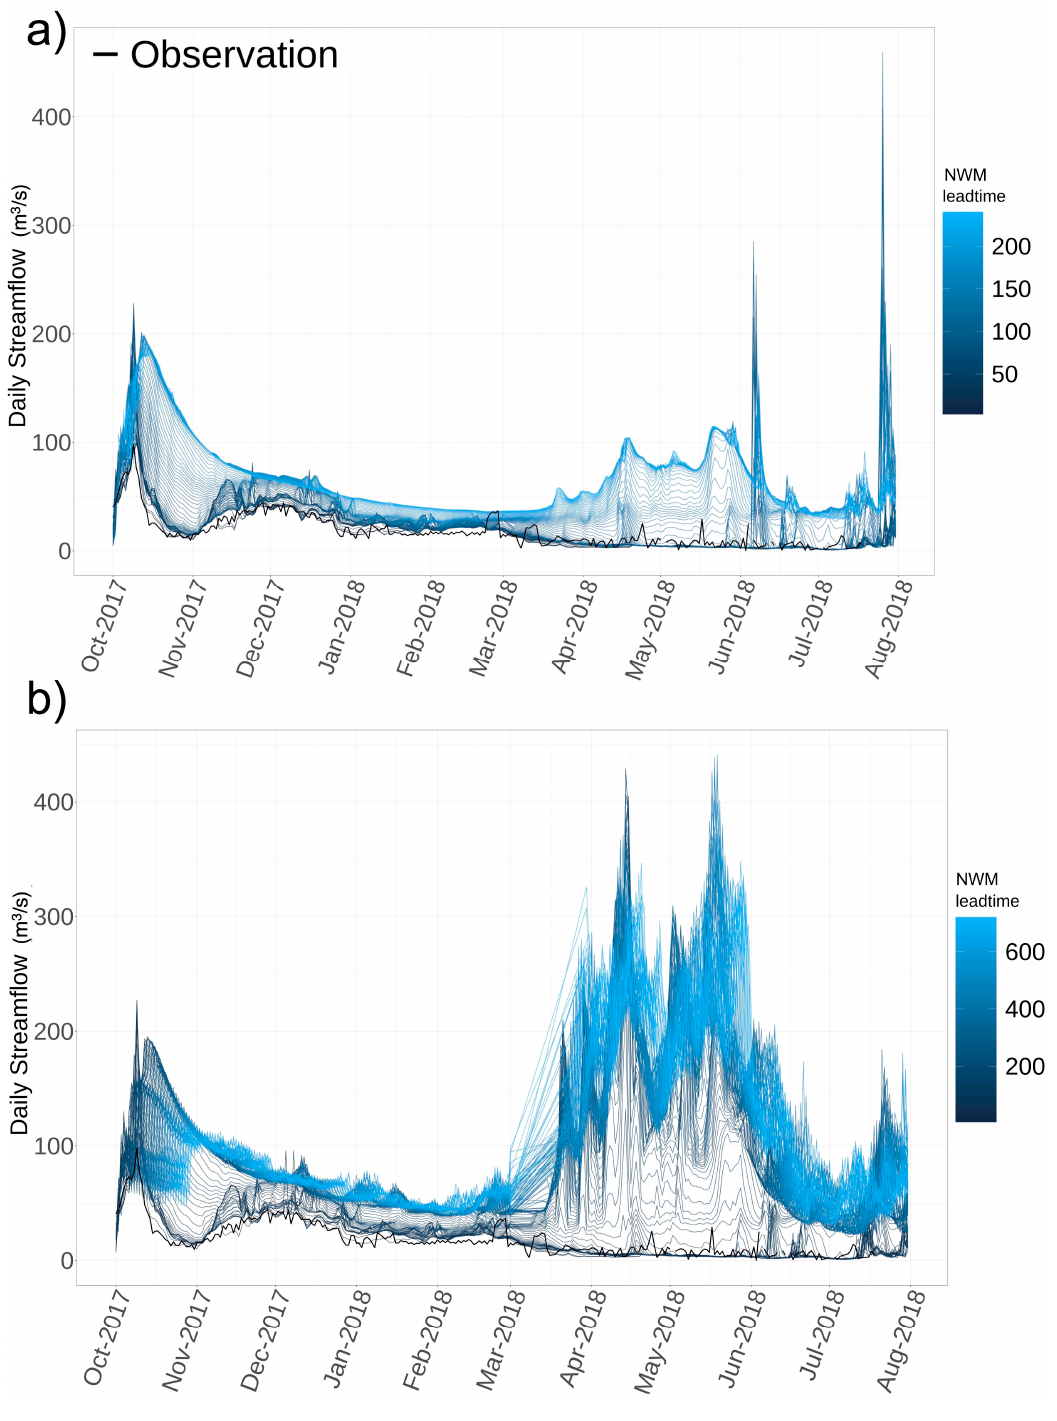
Figure A5. NWM simulated reservoir inflows into Elephant Butte Reservoir for a one − year forecast period for medium ( a ) and long range ( b ). Blue lines are the modeled flows for all lead times and black is the BoR observations.